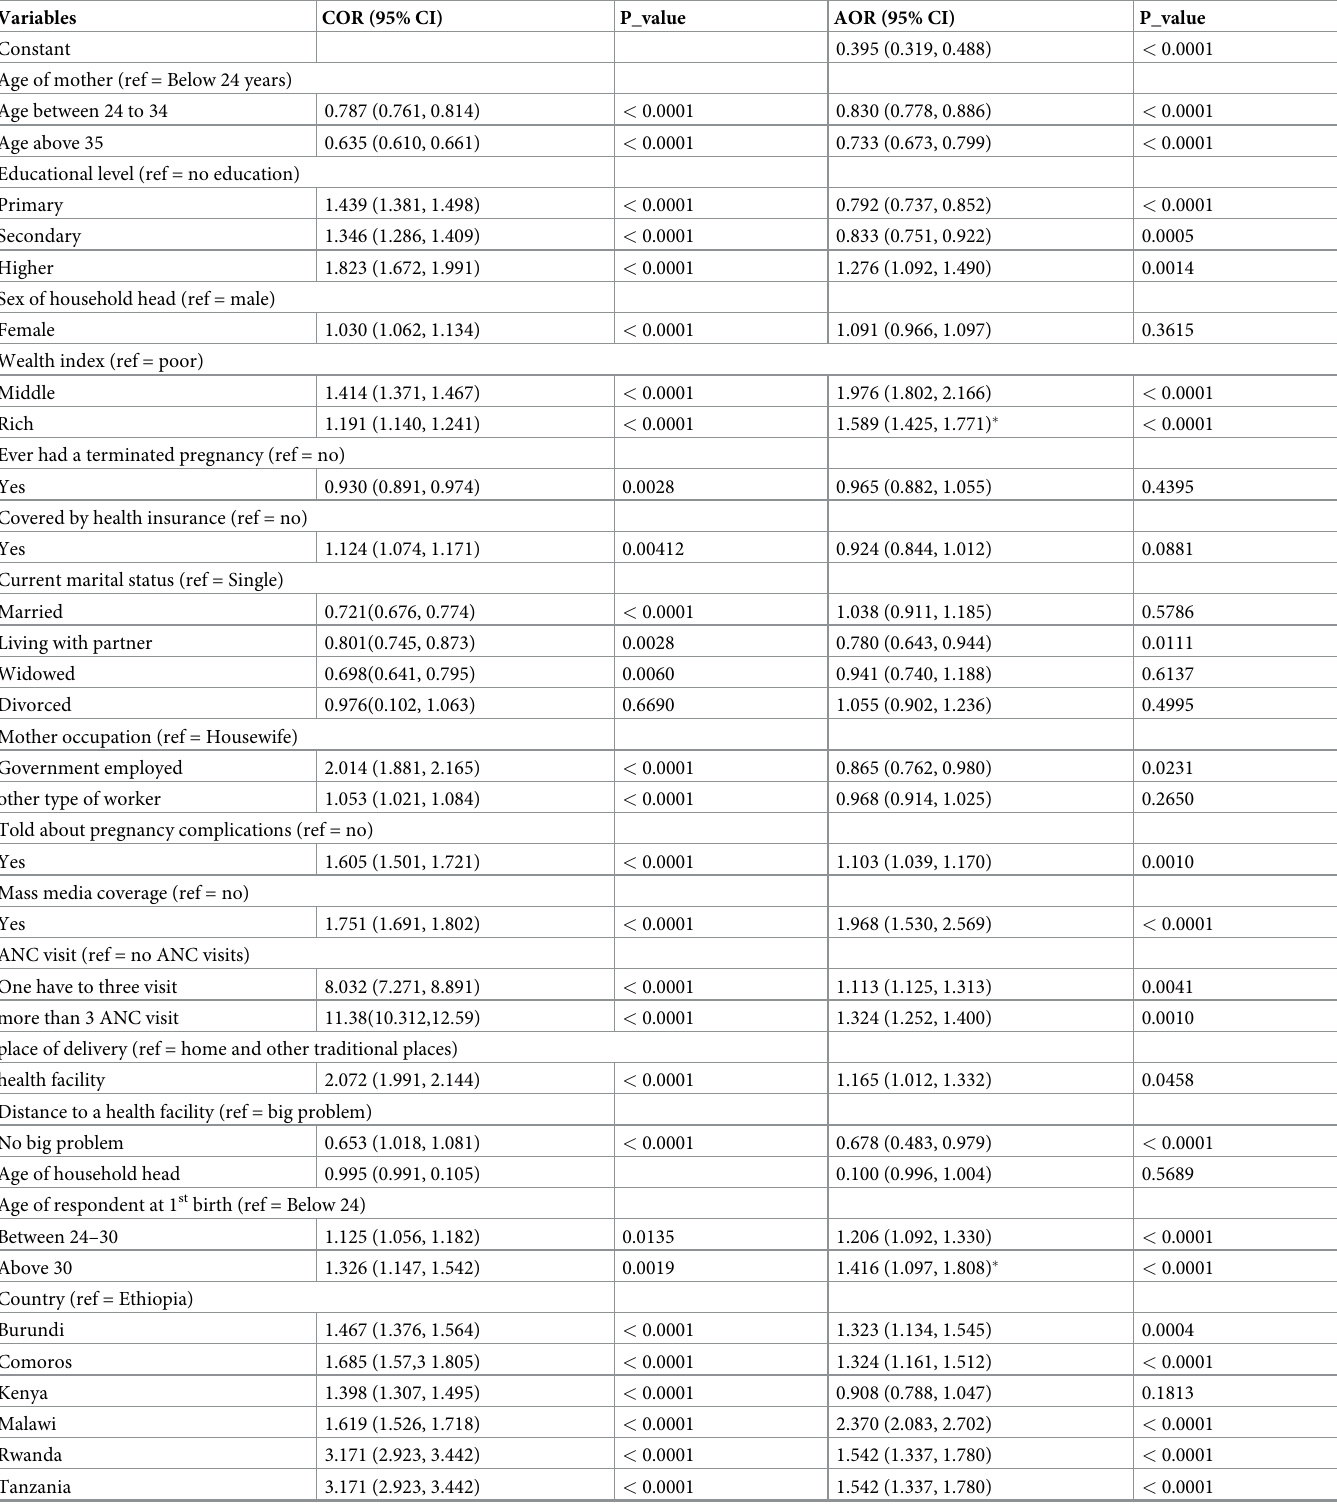
Table 5. Risk factors associated with rural women’s protection from tetanus in 9 East Africa countries from